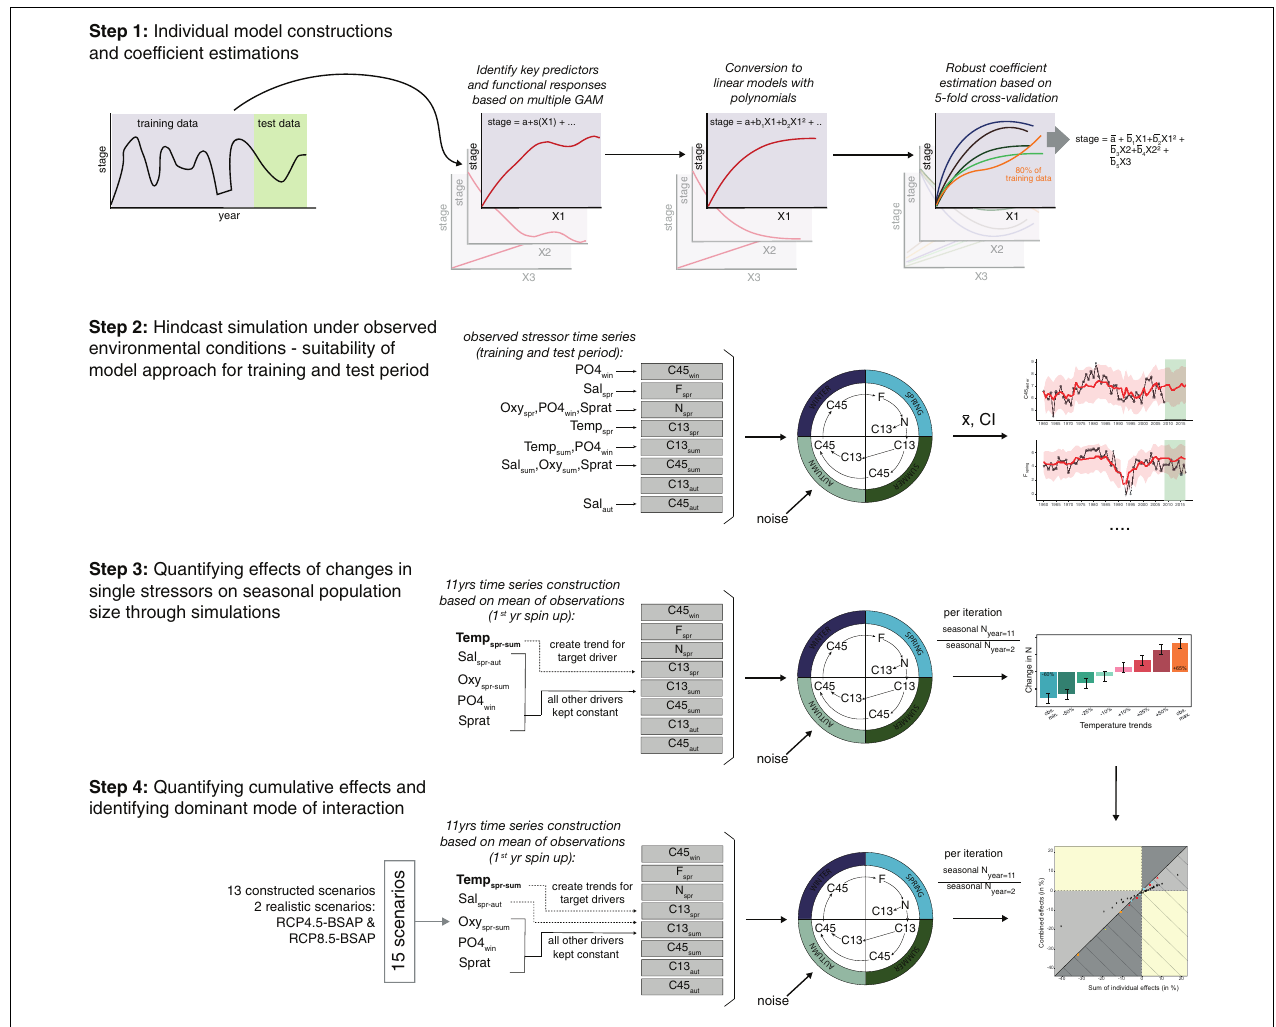
FIGURE 1 | Conceptual diagram of the study design (steps 1–3) . Single stage models of nauplii (N), young copepodites 1-3 (C13), old copepodites 4-5 (C45) and females (F) in the different seasons were constructed (step 1) and coupled to a stochastic life cycle model. This model was then forced by observed past external conditions (step 2) , and by simulated environmental conditions to test for individual (step 3) and combined stressor effects (step 4)